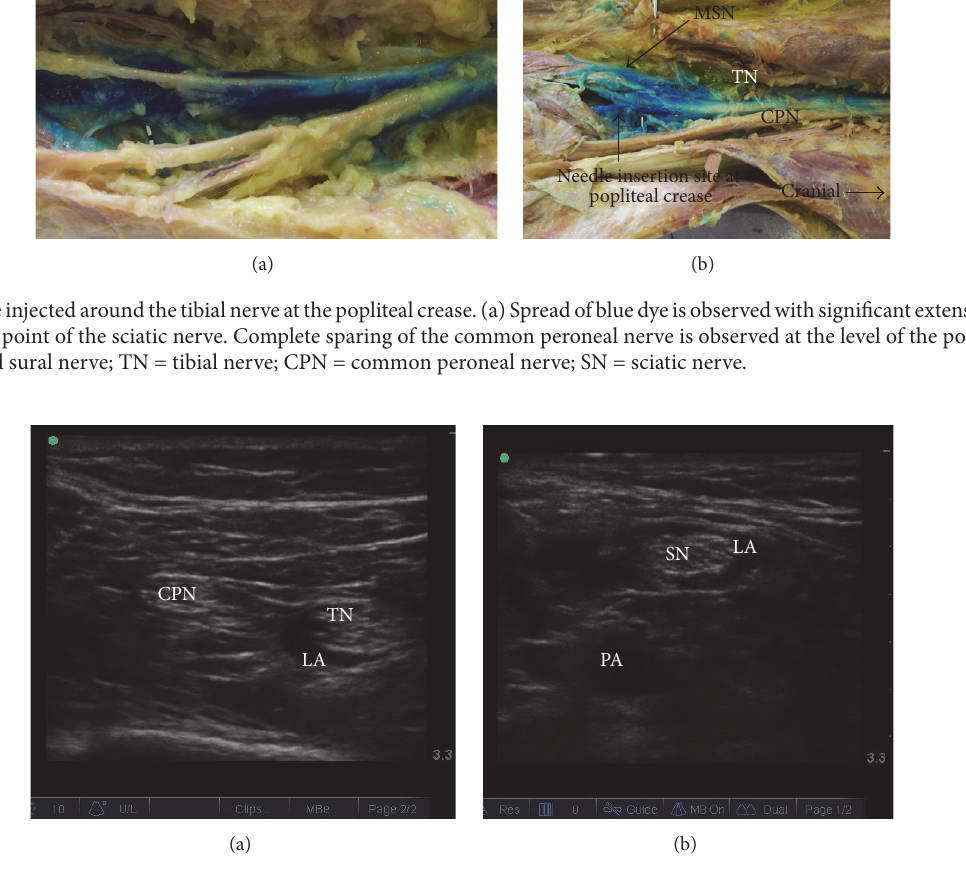
Figure 2: Ultrasound image of the common peroneal nerve and tibial nerve at the popliteal crease after selective tibial nerve block. Local anesthetic was observed around the tibial nerve but not the common peroneal nerve. (a) Local anesthetic could be traced proximally toward the bifurcation which was observed to encircle the sciatic nerve proximal to the bifurcation, (b) CPN = common peroneal nerve; TN = tibial nerve; LA = local anesthetic; SN = sciatic nerve; PA = popliteal